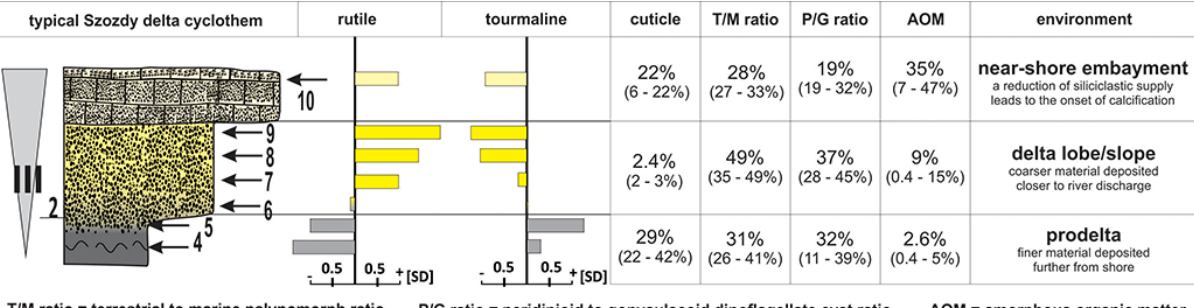
Figure 9. The proposed environment for the successive lithofacies within an individual cyclothem in the Szozdy delta, coupled with the vertical distribution of selected heavy minerals and palynofacies indicators: cyclothem III adopted from Fig. 6. The values in brackets show the range for the lithofacies across all studied cyclothems. SD: standard